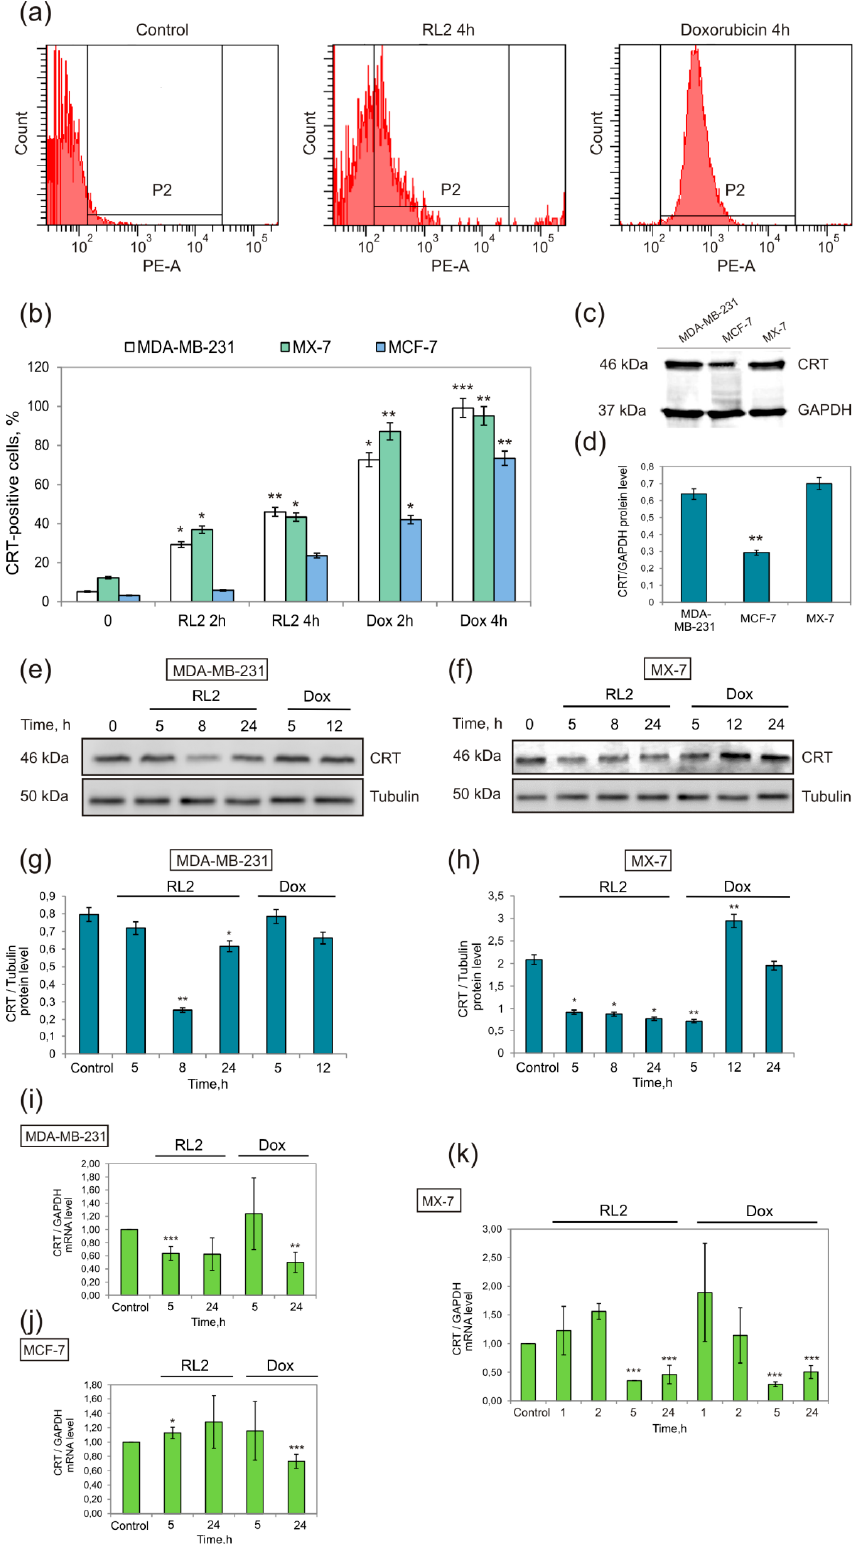
Figure 1. RL2 changes ecto-CRT in treated cells. Cells were treated with RL2 (0.3 mg/mL) or Doxorubicin (Dox, 0.1 μ g/mL) for the indicated time. ( a ) Representative images of flow cytometry analysis of